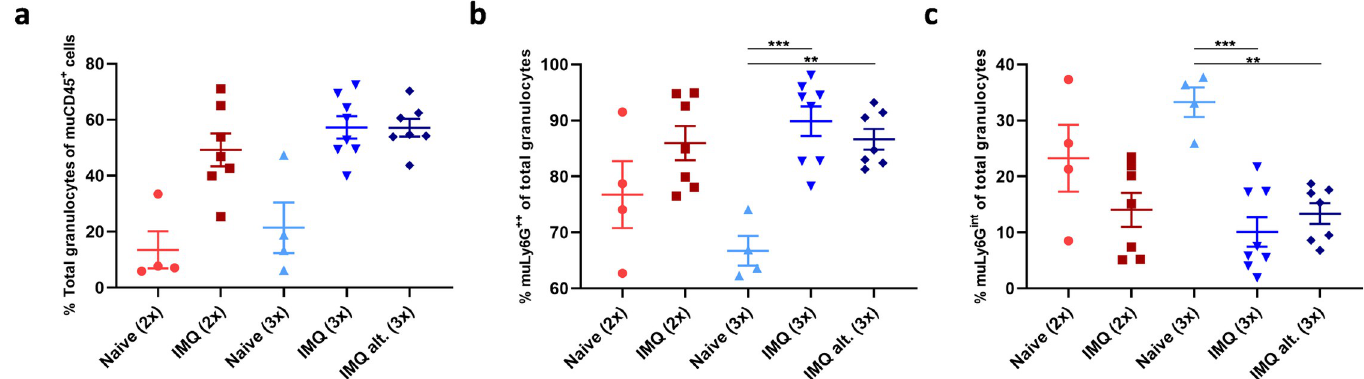
Fig 9. Murine granulocytes in spleen cell suspensions. (a) Percent total murine granulocytes of murine CD45 + cells (Percentage calculated as: (#muLy6G + + #muLy6G int ) / #muCD45 + cells)). Percent mature (b) and immature (c) murine granulocytes of total granulocytes analyzed by flow cytometry at terminations. One mouse was excluded from IMQ alt. (3x) group due to shifting of the Ly6G population which made it difficult to distinguish between the two sub-populations.